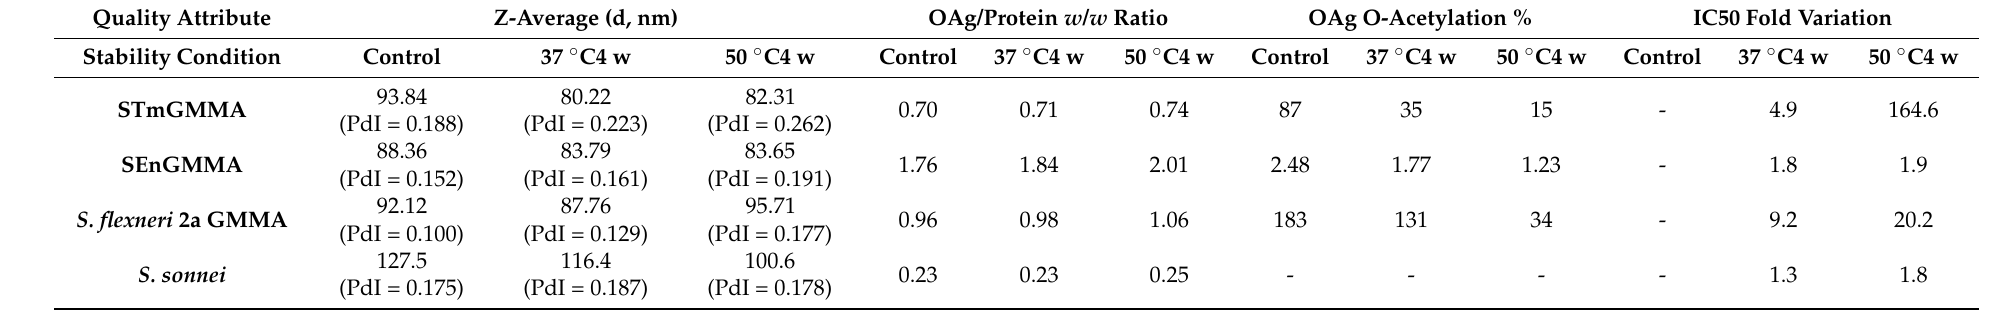
Table 2. Characterization of S . Typhimurium, S . Enteriditis, S. flexneri 2a and S. sonnei GMMA at pH 6.5 stressed at 37 ◦ C and 50 ◦ C for 4 weeks and compared to control GMMA. Quality